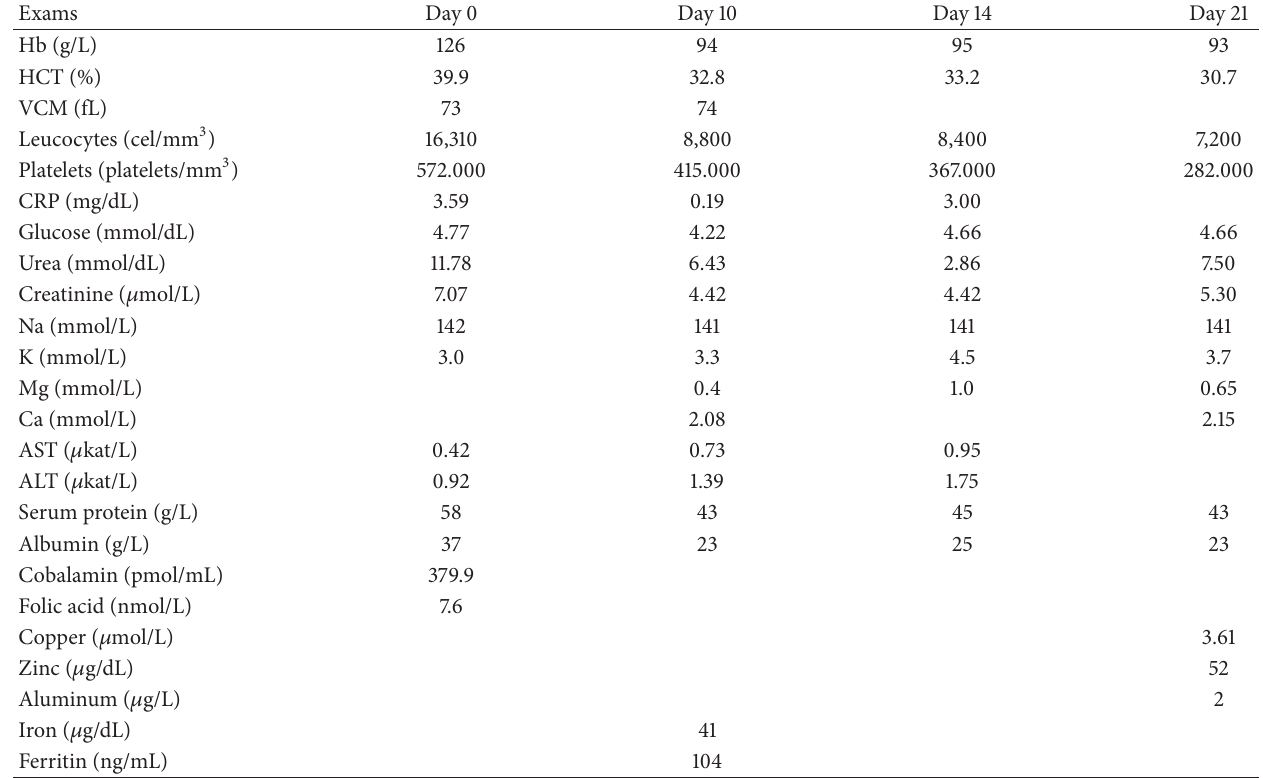
Table 1: Laboratorial exams.